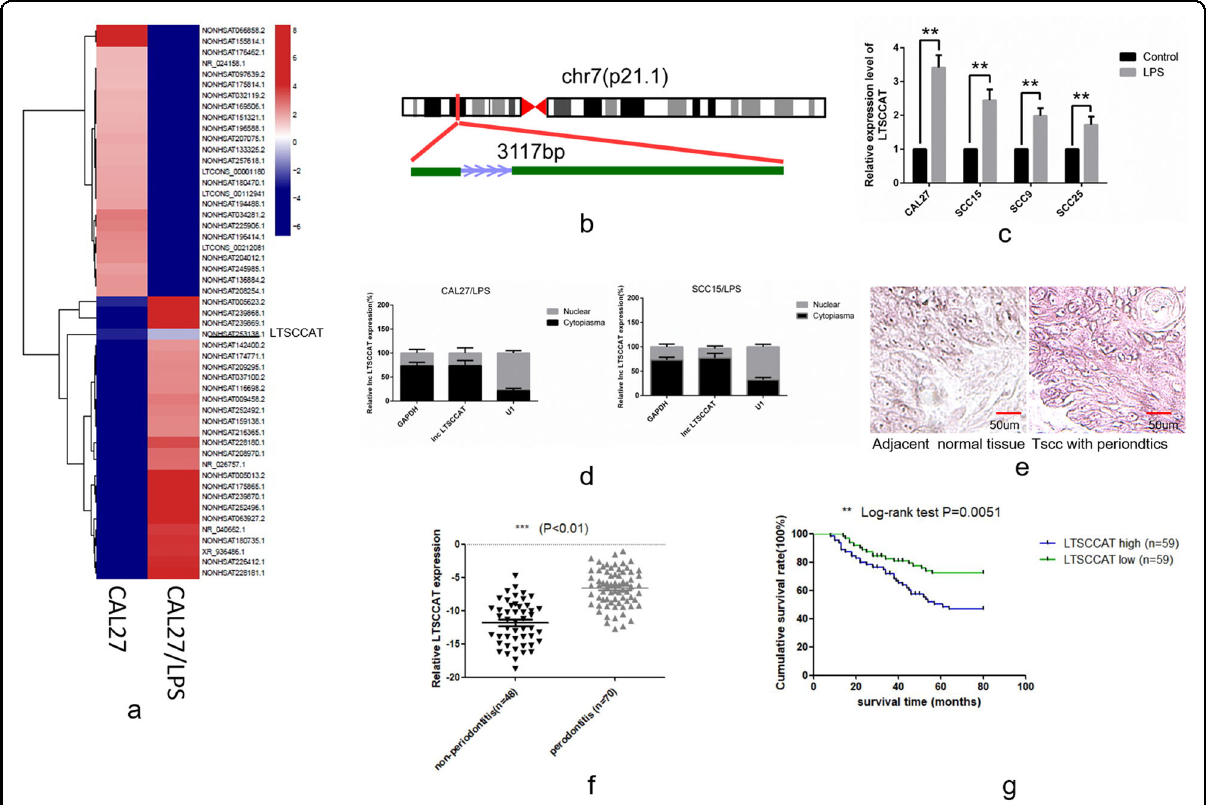
Fig. 2 Expression and clinical value of LTSCCAT in tongue squamous cell carcinoma. a Heat maps were generated based on the sequencing results, showing the expression levels of LncRNA in CAL27 and CAL27/LPS cells (unsupervised cluster analysis). Each row represents one LncRNA, the left column represents the expression of CAL27 cells, and the right column represents the expression of P.g-LPS-induced CAL27 cells. Red represents a high expression level, and blue represents a low expression level. b According to the sequencing results of LncRNAs, LTSCCAT located 113 bp downstream of the Twist1 gene has a homeostatic effect on Twist1 expression. c The sequencing results were veri fi ed in tongue squamous carcinoma cell lines and showed that P.g-LPS signi fi cantly upregulated the expression of LTSCCAT in CAL27, SCC15, SCC9, and SCC25 cells. Error bars represent the mean±S.D. from three independent experiments. (** P < 0.01). d Nuclear pulp separation experiments showed that LTSCCAT was predominantly expressed in the cytosol. e Representative images of in situ hybridization for LTSCCAT in TSCC with periodontitis tissues and non- periodontitis tissues (scale bar: 50 µm). f The expression of LTSCCAT in clinical specimens was detected by RT-QPCR, indicating that LTSCCAT expression is higher in patients with periodontitis than in those without periodontitis. (** P < 0.01). g Kaplan – Meier analysis revealed that high expression of LTSCCAT is associated with poor prognosis. The p values were assessed by the log-rank test. (** P < TSCC patients with periodontitis was higher than that in TSCC patients without periodontitis (Fig. 2f). As expec-